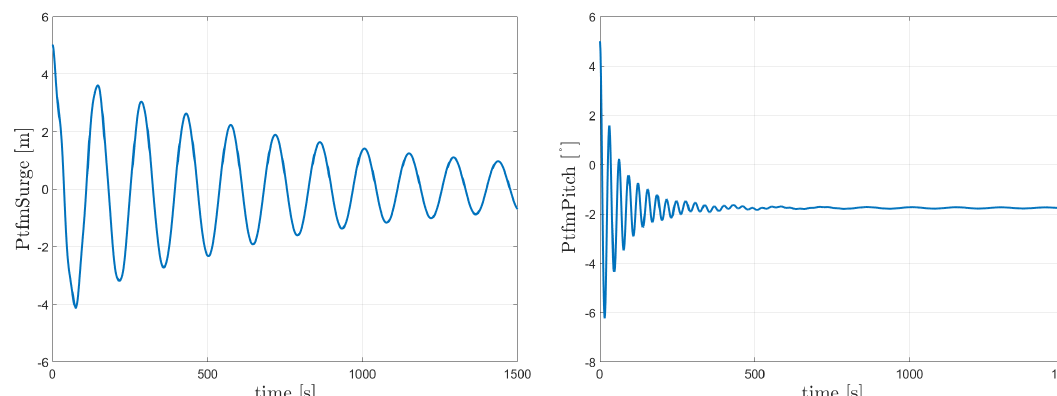
Figure 4. Activefloat surge and pitch